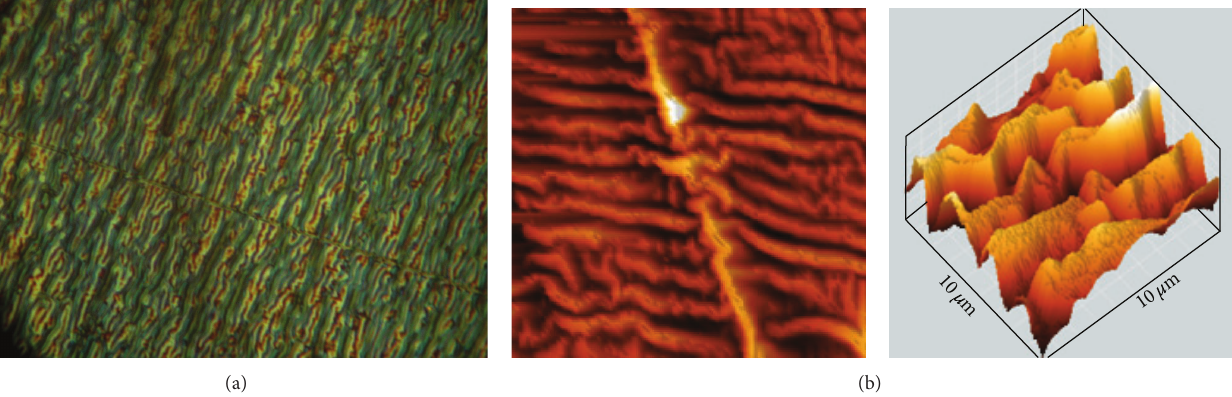
F 10: (a) Optical microphotos (size of 120 treatment while untreated �lm is smooth. (b) �FM image of polyethylene surface aer PIII. e lateral scale is 30 (right image). Vertical scale is 1